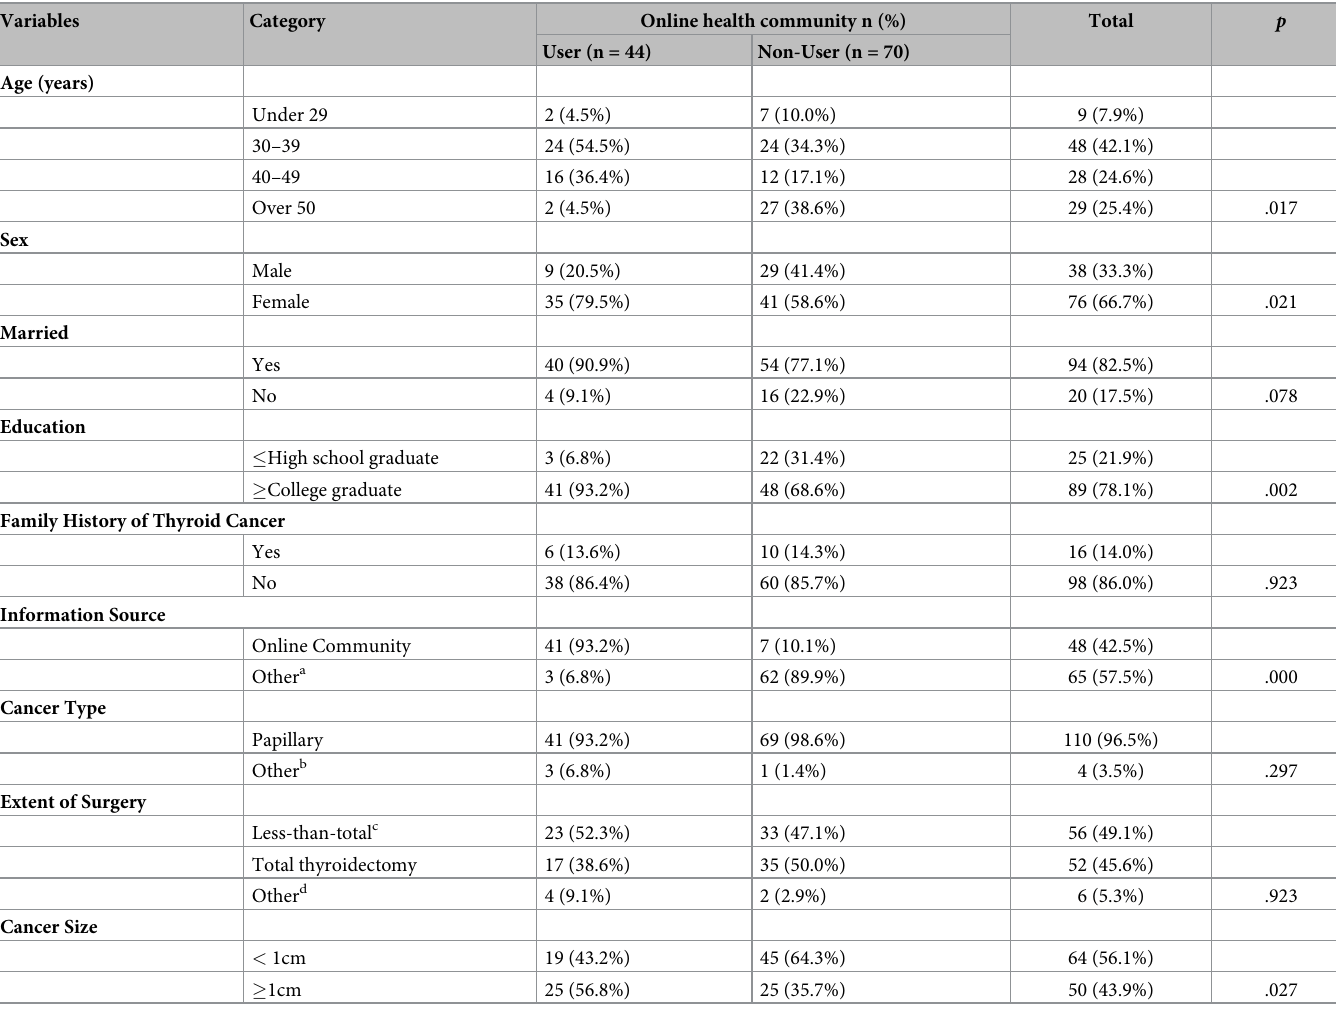
Table 1. Characteristics of online health community users and non-users (n =